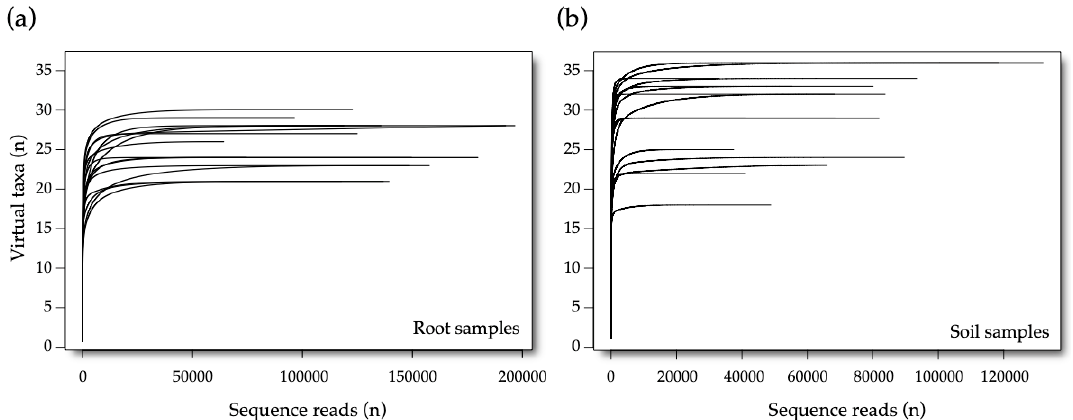
Figure A1. Rarefaction curves showing the relationship between sequencing depth and the number of found Virtual Taxa per sample. ( a ) Root samples. ( b ) Soil samples. Table A1. Abundance of Glomeromycotan families (% of reads in the Illumina run) for the whole study and for soil and root sample separately.